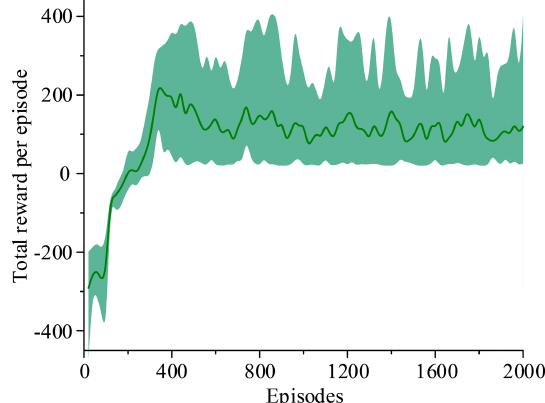
Figure 16. The total reward per episode with states descriptor